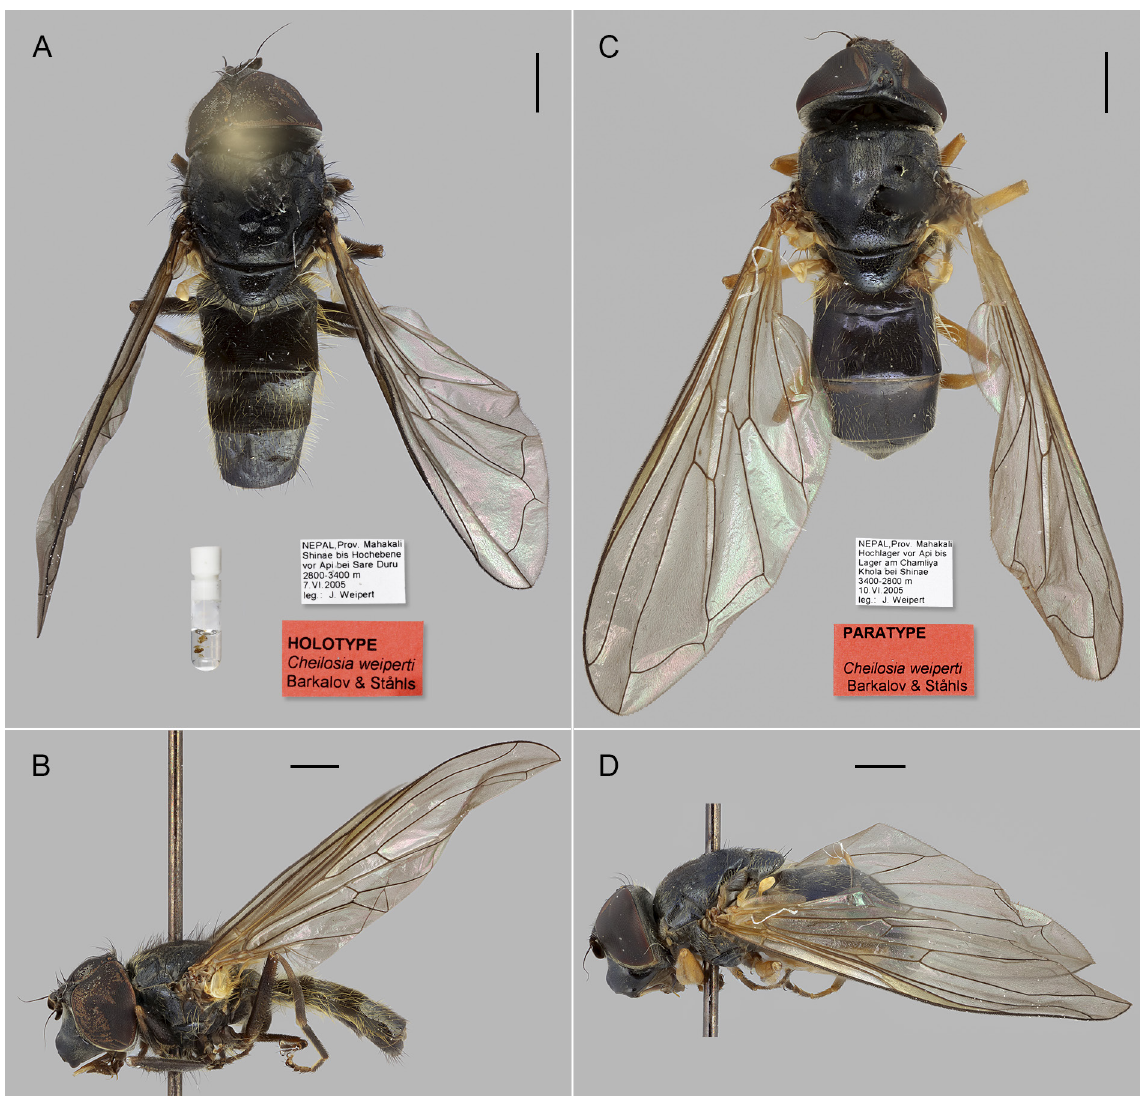
Fig. 67. Cheilosia ( Cheilosia ) weiperti sp. nov. A–B . Holotype, ♂ (BSJW/NME); dorsal and lateral views. C–D . Paratype, ♀ (BSJW/NME); dorsal and lateral views. Photo: Pekka Malinen, FMNH Luomus. Scale bars = 1